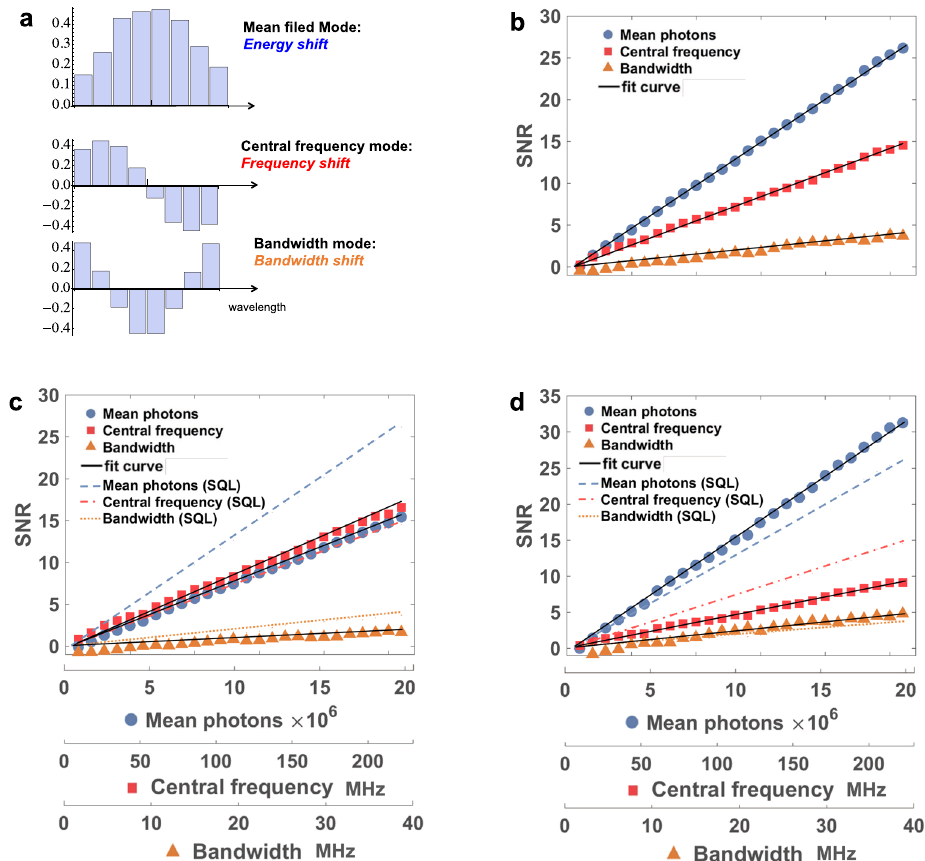
Fig. 5 Signal-to-noise ratio (SNR) measurements of multi-parameters. a Experimental detection modes corresponding to the mean fi eld (top), the central frequency mode (middle), and the bandwidth mode (bottom), which are reconstructed based on the mean fi eld. b – d SNRs for mean fi eld (blue curves) and central frequency mode (red curves) as well as spectral bandwidth mode (orange curves) while increasing the modulation depth of displacement, b when the other port of the beam splitter is vacuum, c quantum frequency comb with a squeezed central frequency mode, and ( d ) quantum frequency comb with a mean fi eld and a bandwidth mode squeezed at the same time. The measured standard quantum limit (SQL) presented in ( b ) is added in ( c and d ) (dashed lines). As the system is well locked and many events are used in the measurements, error bars for each SNR point are small (<2%), and are thus not drawn for